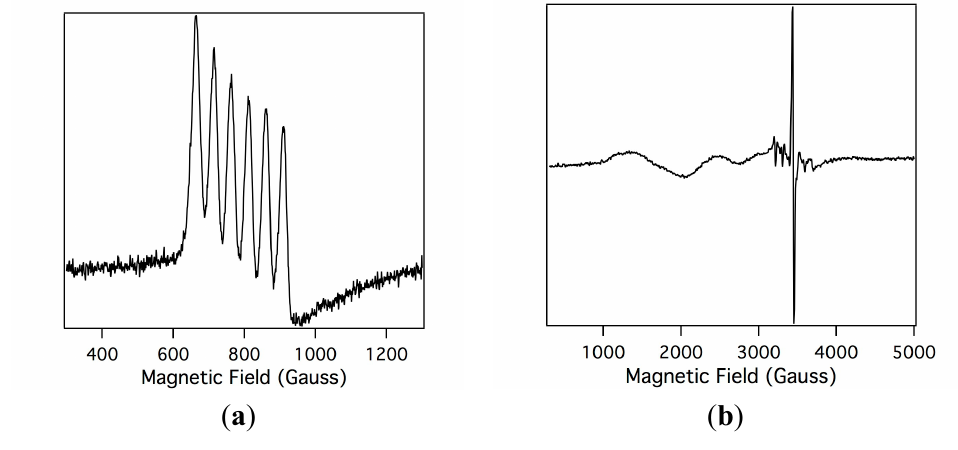
Figure 4. X-band electron paramagnetic resonance spectroscopy (EPR) spectrum of Mn(III)-myoglobin (1 mM in 10 mM phosphate buffer pH = 7) in parallel mode ( a ); and the EPR spectrum of the intermediate after Mn(III)-myoglobin is reacted with m CPBA in perpendicular mode ( b ). Experimental conditions: microwave frequency, 9.47 GHz; microwave power, 20.26 mW; modulation amplitude, 10.02 G; temperature,